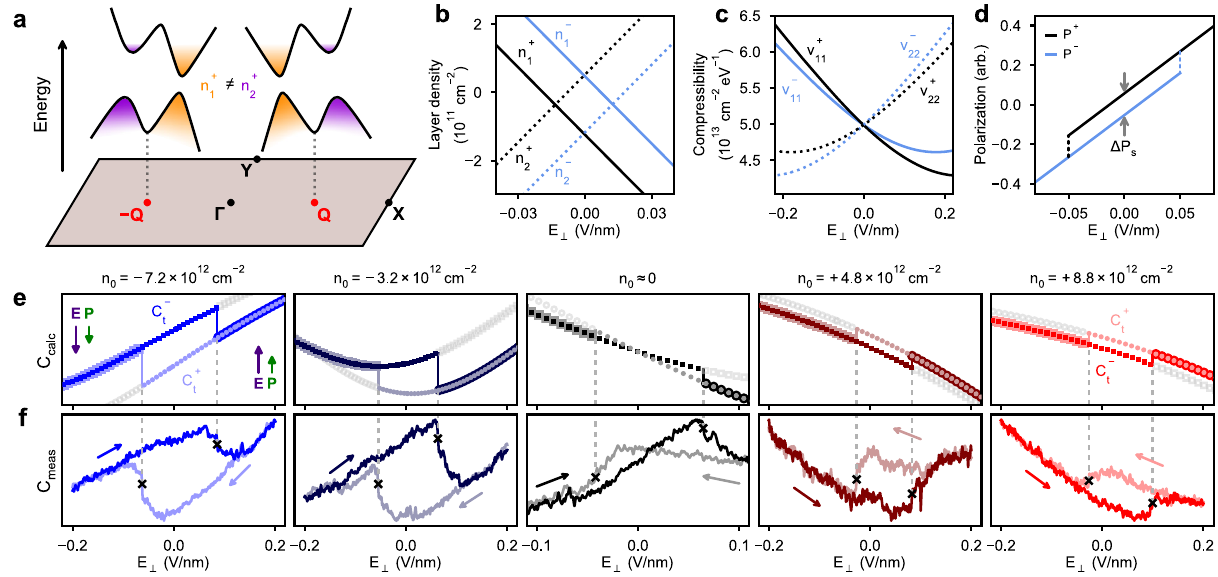
Fig. 3 Layer-polarized bands yield distinct capacitance branches for each polarization state. a Schematic low-energy bands showing layer-polarized valleys (orange and purple) in the P + state, for small electron density and E ⊥ = 0. In the P − state, the colors and layer polarization would be interchanged. Each pair of valleys is centered around a point along Γ – X , labeled Q . Band parameters are exaggerated to emphasize separation of valleys. b Representative (cid:2) n ± calculated layer densities, c compressibilities, and d polarization / n ± in each polarization state, ±, from n 0 ≈ 0. e Computed top capacitances, C þ 1 2 t and C (cid:2) in the P + and P − states, respectively, for the listed densities versus electric fi eld, with colored symbols indicating the hysteretic path observed in t experiment, while gray symbols denote portions of each capacitance branch that are inaccessible in experiment due to switching behavior (switching fi elds are not computed in the model; solid vertical lines are shown extending from experimental switching fi elds in f to re fl ect the loop observed in the experiment). Capacitance is calculated using computed layer densities, potentials, and compressibilities to evaluate Eq. (11a). f Measured top capacitance hysteresis loops for matching electron and hole densities in e .